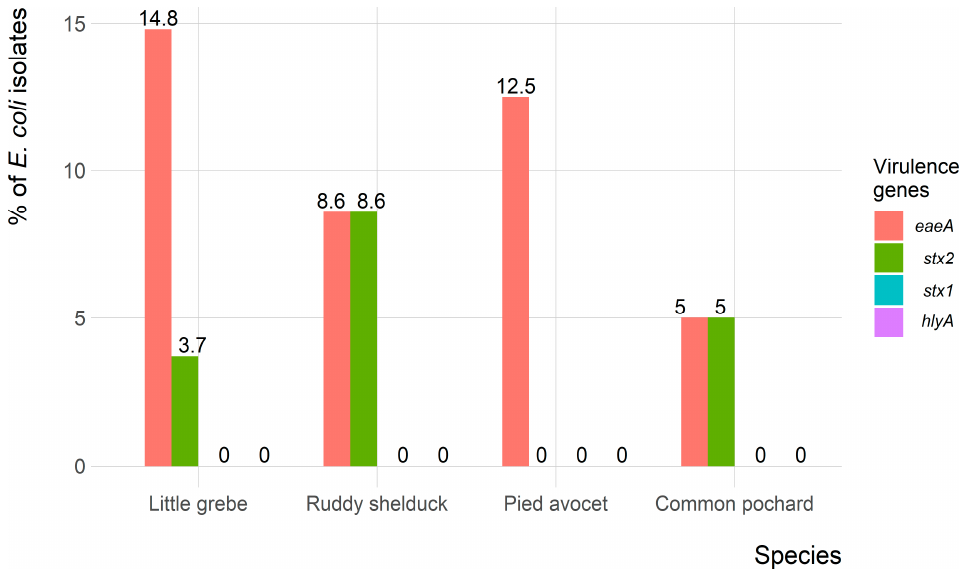
Figure 5. Frequency of virulence genes of Escherichia coli ( n = 90) isolates recovered from migratory wild birds around the Al-Asfar Lake.